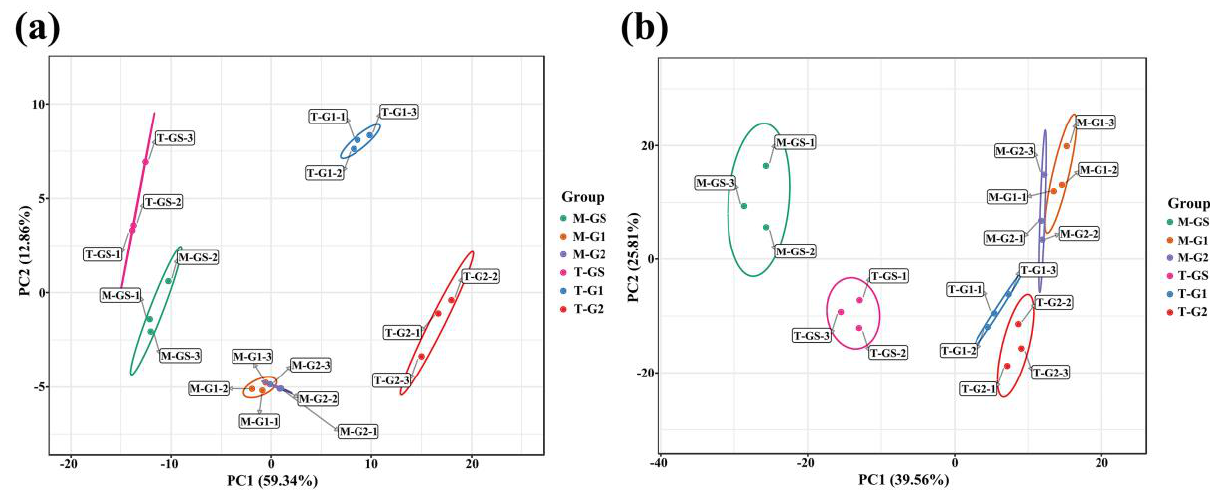
Figure 3. PCA score plot of Shandong matcha and tencha. ( a ) HS − SPME. ( b ) SAFE.